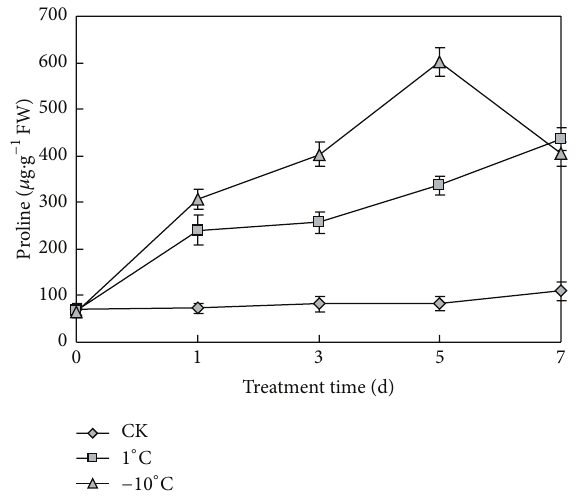
Figure 4: Free proline content of seedling leaves under normal and low temperatures. CK represents normal growth condition. Each value is the average ± standard error ( ± SE) result of three independent measurements.